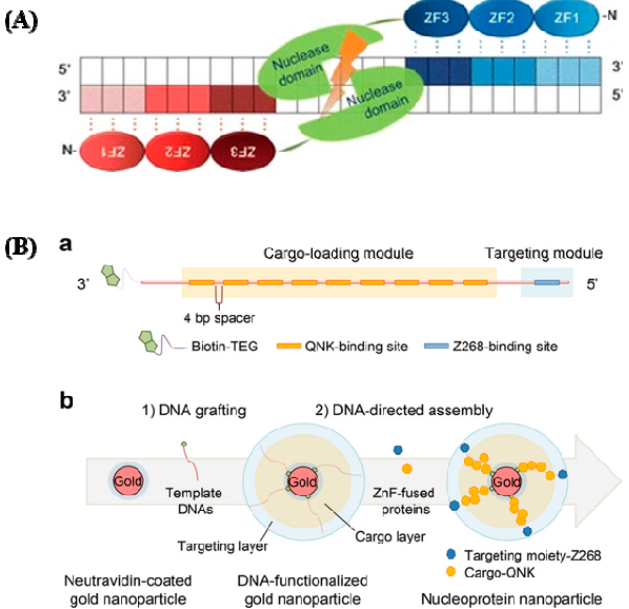
Figure 3. ( A ) ZFNs have a specific structure. ZFNs linked to their target locations are depicted schematically. This is a well-designed ZF DNA domain fused to the FokI type IIS restriction en- zyme’s DNA cleavage domain that forms nucleases. Each ZFN protein has three ZFs (shaded ovals) that recognize a target sequence in the DNA (shaded boxes). The binding of two ZFNs on target DNA with a spacer (5/6 bp) in the center causes the ZFN nuclease domains to dimerize and the target DNA to be cleaved (reprinted with permission from [51]). ( B ) DNA and zinc fingers are used to program the construction of nucleoprotein nanoparticles. ( a ) Template modular DNA design. A biotin molecule was added at the 3 ′ end of the template DNA with a TEG linker for grafting template DNA onto AuNPs. To eliminate steric hindrance, multiple binding sites for QNK-QNK-RHR (QNK) were spatially organized with a four-base-pair spacer. ( b ) Sequential con- struction of nucleoprotein nanoparticles is depicted schematically (NNPs) (reprinted with permis- sion from [52]).